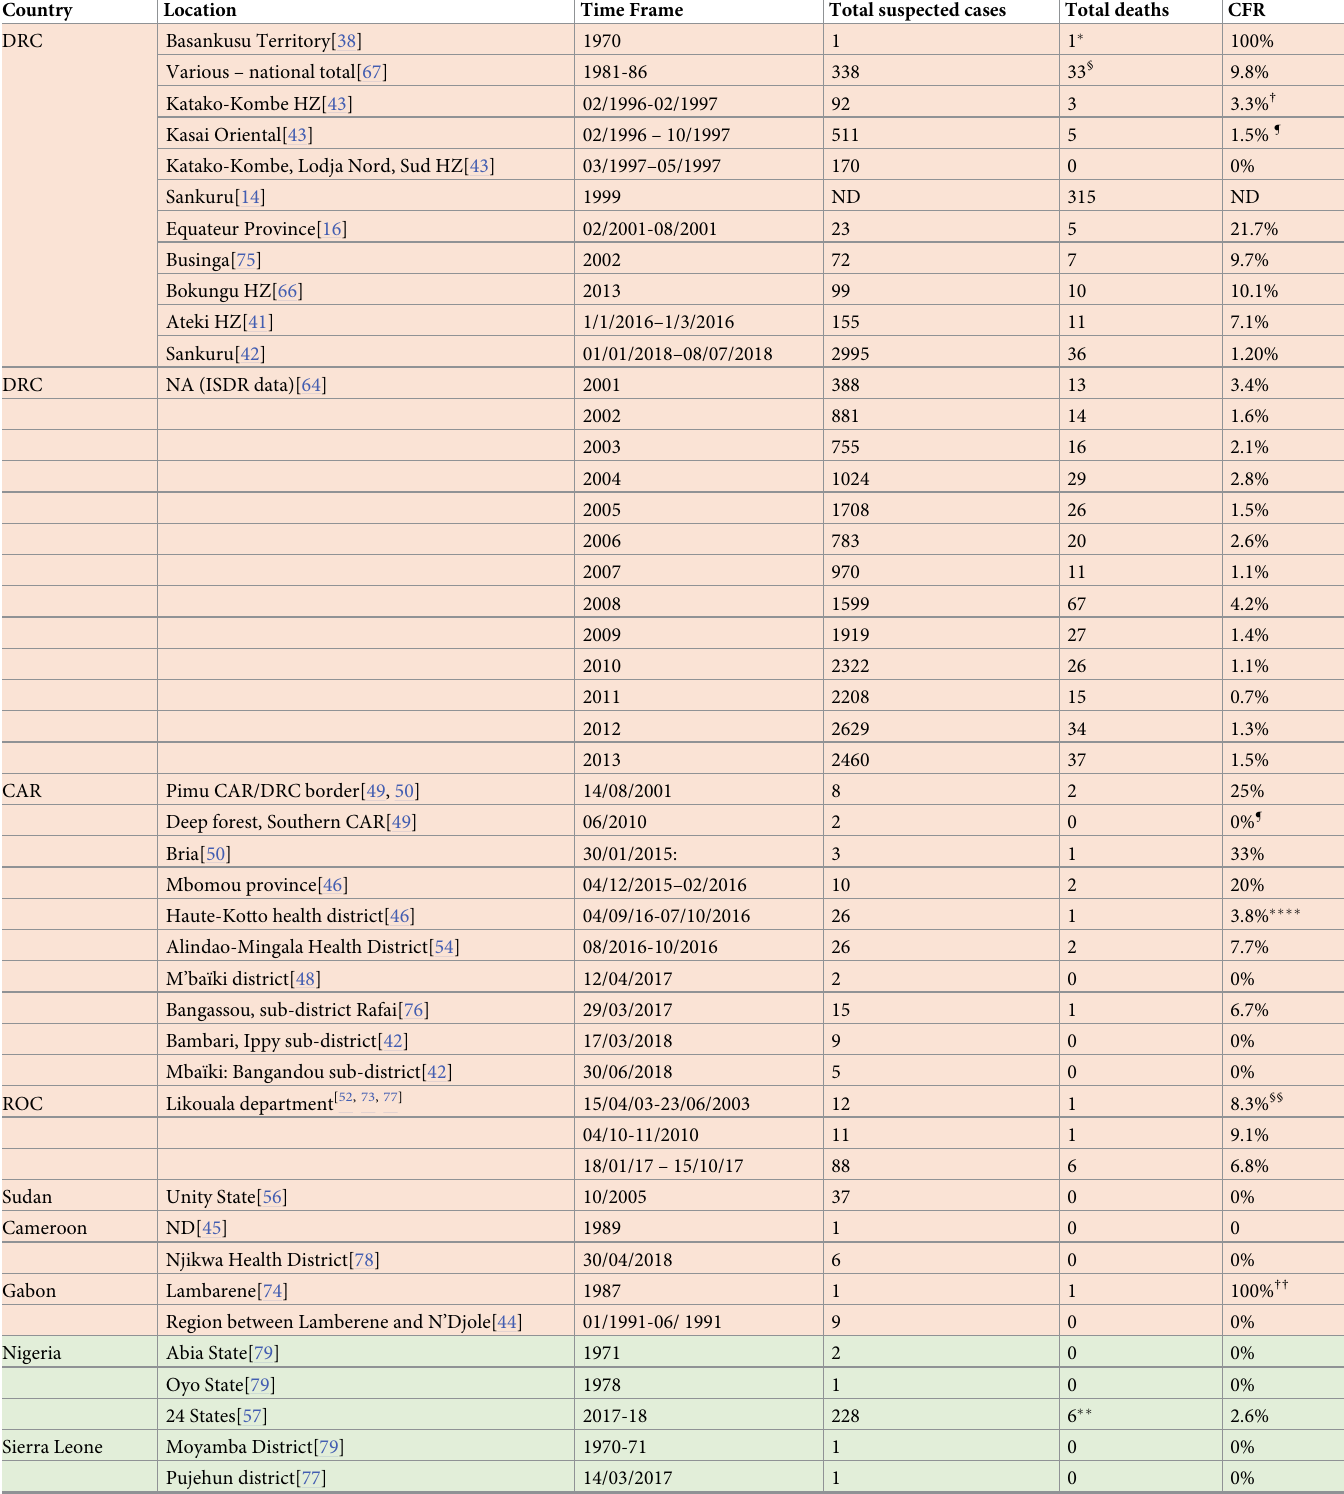
Table 1. CFR by country and